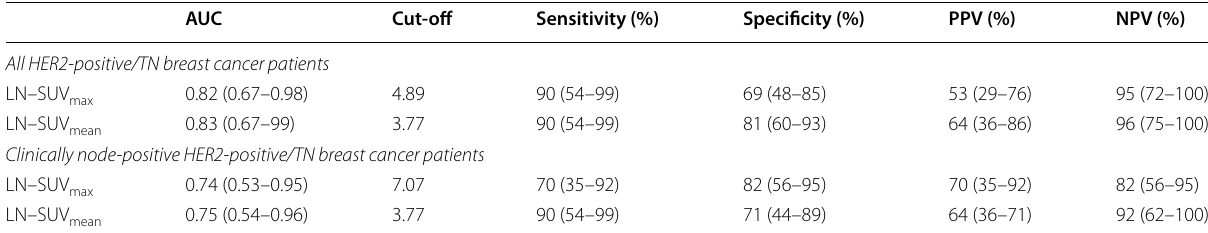
AUC, area under the curve; HER2, human epidermal growth factor 2 receptor; LN, lymph node; NPV, negative predictive value; PPV, positive predictive value; SUV, standardized uptake value; TN, triple negative